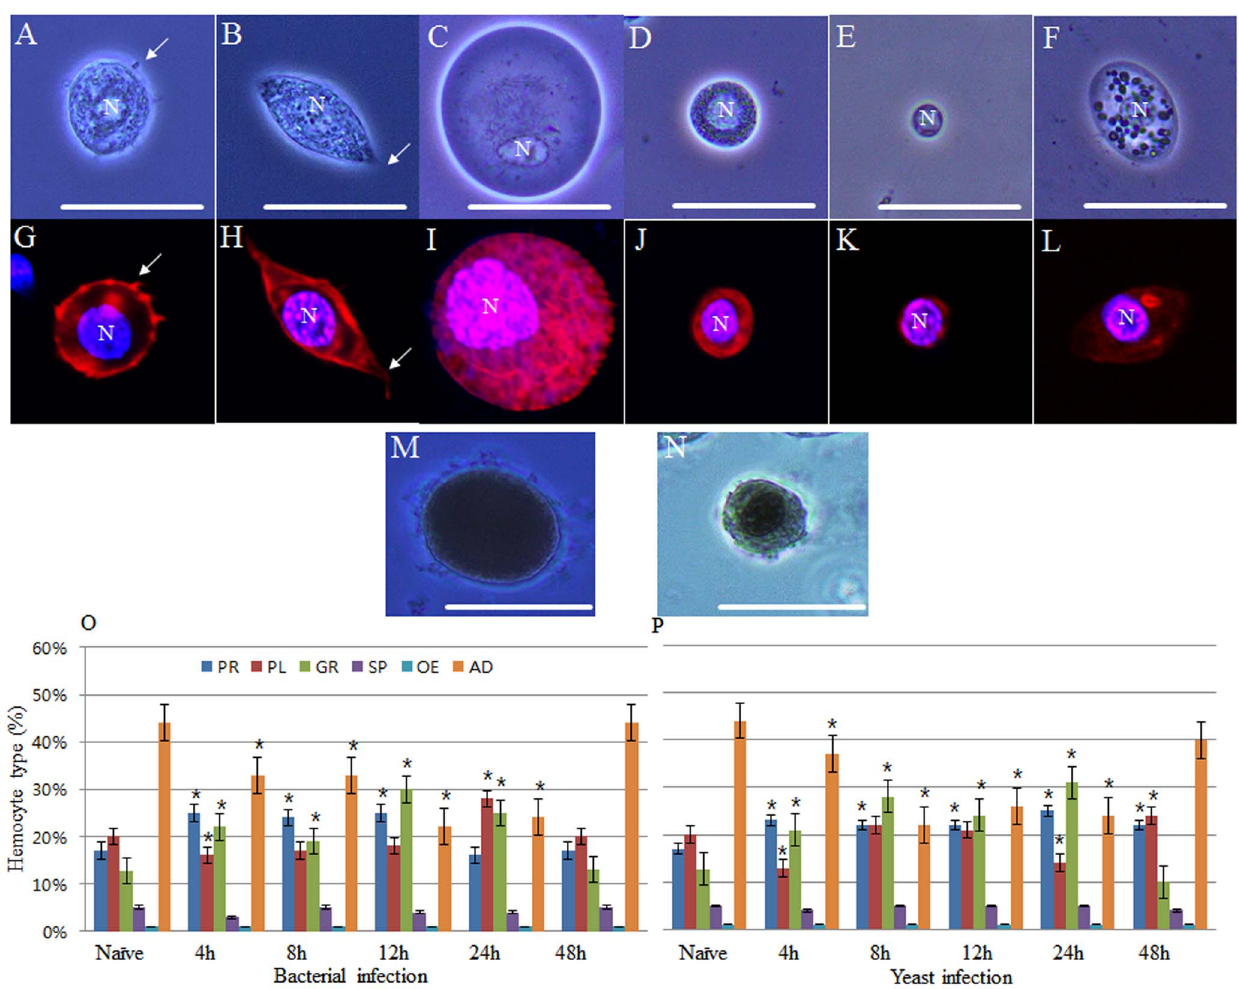
Figure 1. Images of hemocytes and average proportional distribution of circulating hemocytes in naı¨ve and challenged larvae. Confocal images of hemocytes stained with DAPI (blue) for nuclei (N) and with filamentous actin (F-actin; red) for cytoskeleton visualization. Hemocytes were classified as granulocytes (A and G), plasmatocytes (B and H), oenocytoids (C and I), spherulocytes (D and J), prohemocytes (E and K), and adipohemocytes (F and L) on the basis of their size, morphology, and dye-staining properties. Pseudopodia or filopodia on the plasma membrane, are indicated by white arrow (A, B, G, and H). The panels M and N show melanized oenocytoids (M) and granulocyte (N). Hemocyte counting was performed by differential hemocyte count (DHC) and 35 larvae (11,235 hemocytes; 321 hemocytes per larva) were used to determine the percentage of the six circulating hemocyte types; five naı¨ve larvae and three challenged larvae at each time point (4, 8, 12, 24, and 48 h) post infection. Results are given as means and standard deviation. *(P , 0.05). Challenged larvae were infected with E . coli (panel O) or S . cerevisiae (panel P) whereas naı¨ve larvae were injected with sterile saline solution. PR, prohemocytes; PL, plasmatocytes; GR, granulocytes; SP, spherulocytes; OE, oenocytoids; AD, adipohemocytes. Scale bar=20 m